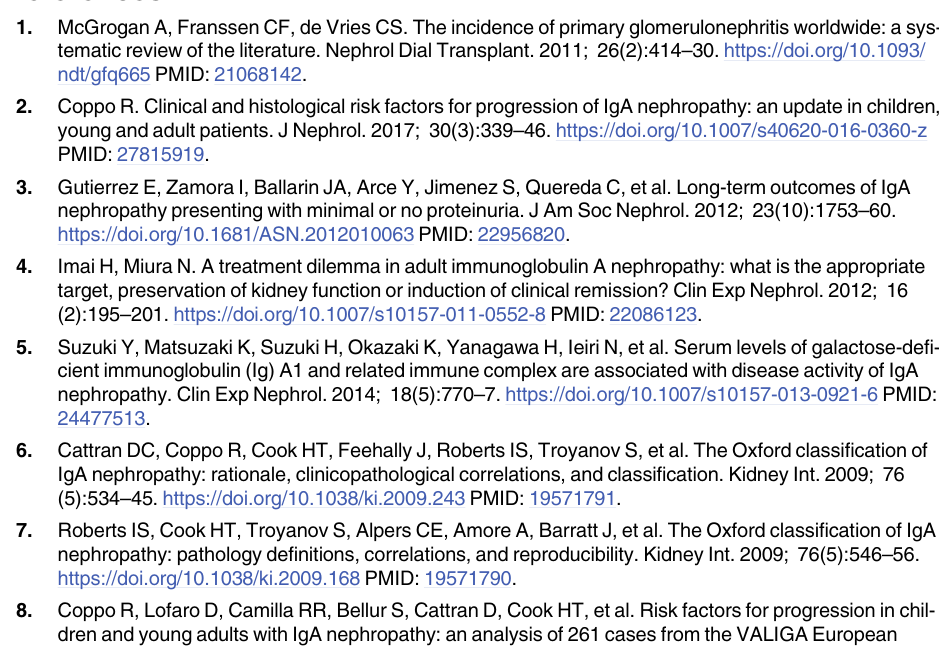
S1 Table. Risk stratification for dialysis according to the criteria of the Japanese Society of Nephrology. S2 Table. Comparison of immunosuppressive treatment among study groups when renal biopsies were